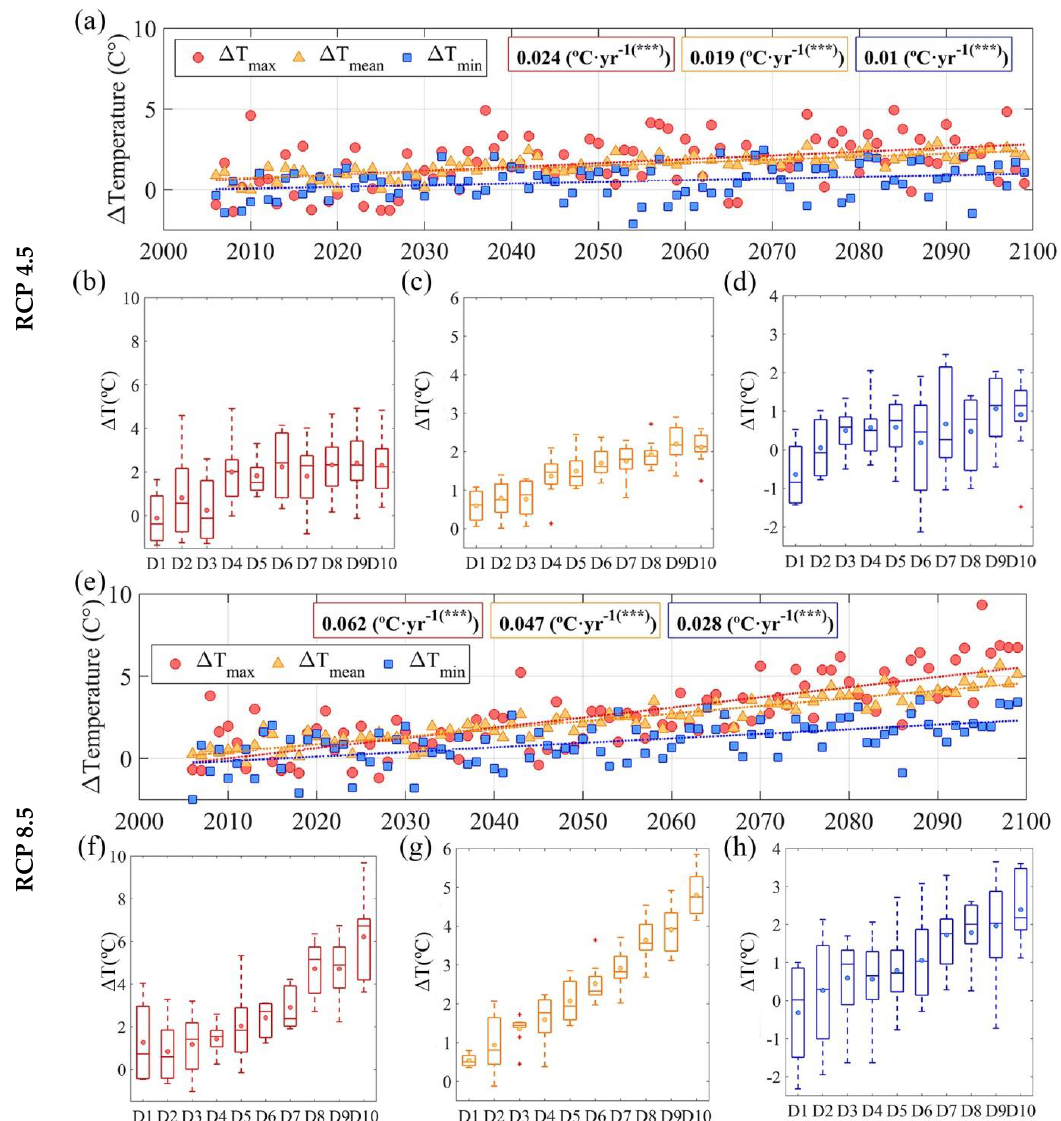
Figure 3. Evolution of the ( a , e ) annual mean, maximum, and minimum daily temperature anomalies and decadal ( b , f ) maximum, ( c , g ) mean, and ( d , h ) minimum temperature anomalies for the two climate change scenarios analyzed, respectively, during the period of 2006–2100. The trend analysis results are defined according to the Mann-Kendall test as having either (1) excellent significance, 99% (***); (2) good significance, 95% (**); (3) acceptable significance, >90% (*); and (4) no significance, less than 90% (+).